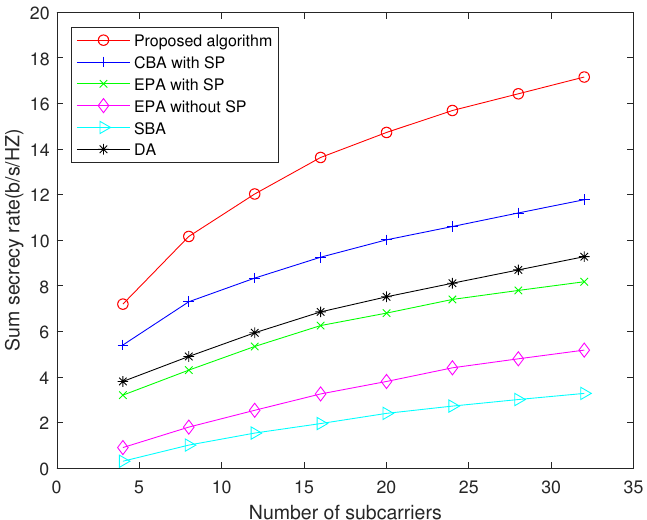
Figure 4. Sum secrecy rate versus number of subcarriers when transmit power per node is 20 dBm.